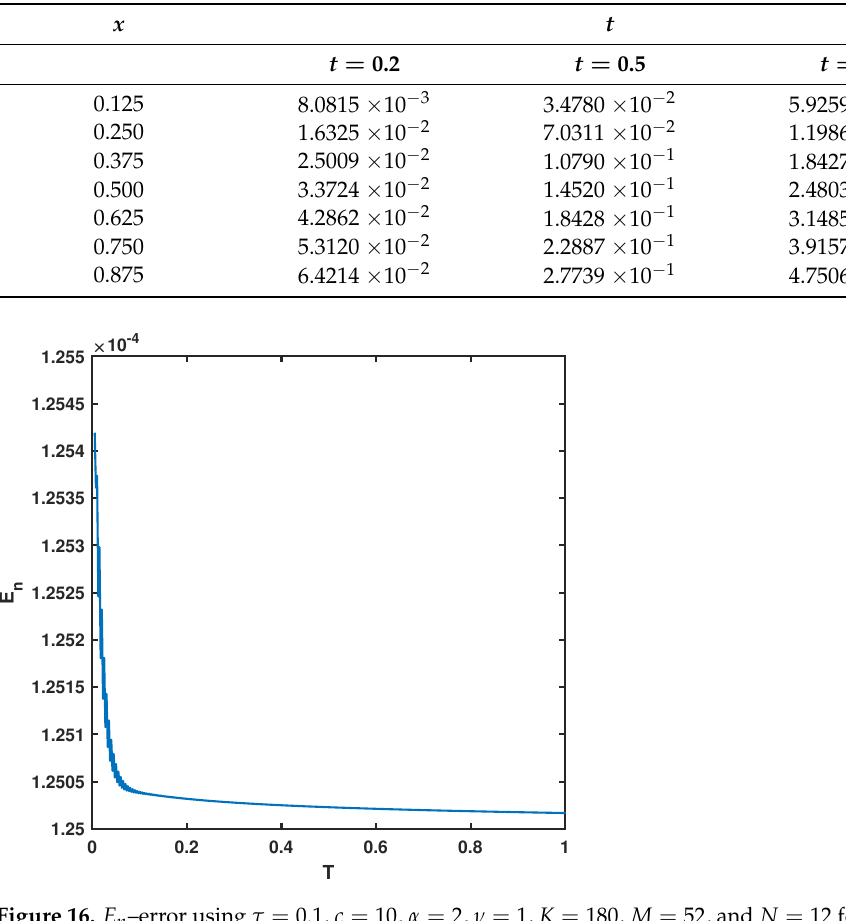
Figure 16. E n –error using τ = 0.1, c = 10, α = 2, ν = 1, K = 180, M = 52, and N = 12 for Example 5.